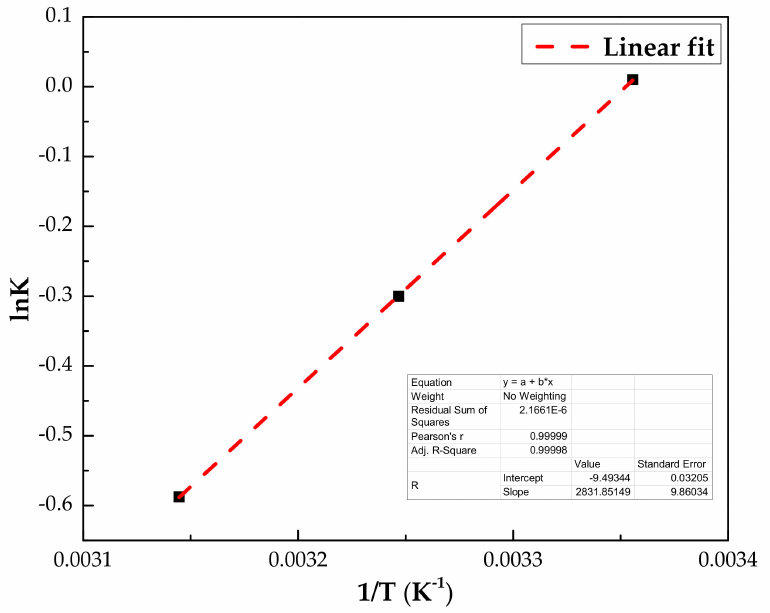
Figure 15. Van’t Hoff plot for the adsorption of phenol on the IL–agar–alginate